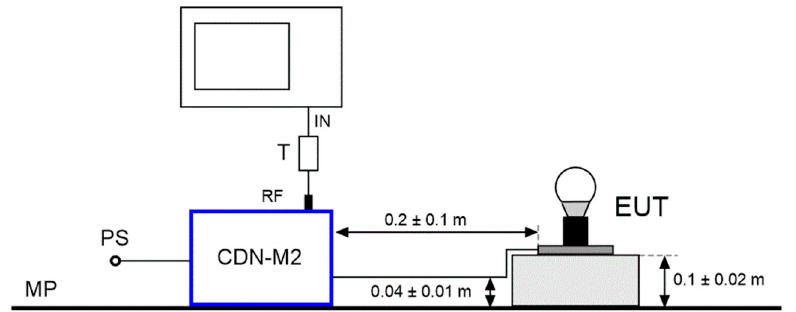
Figure 2. Test setup for testing lighting devices using the CDME method in accordance with EN 55015:2013: PS—power supply, R– measuring receiver ESU-26, CDN-M2—coupling and decoupling network, T—attenuator 6 dB, EUT—tested LED lamp, MP—grounded metal plate.